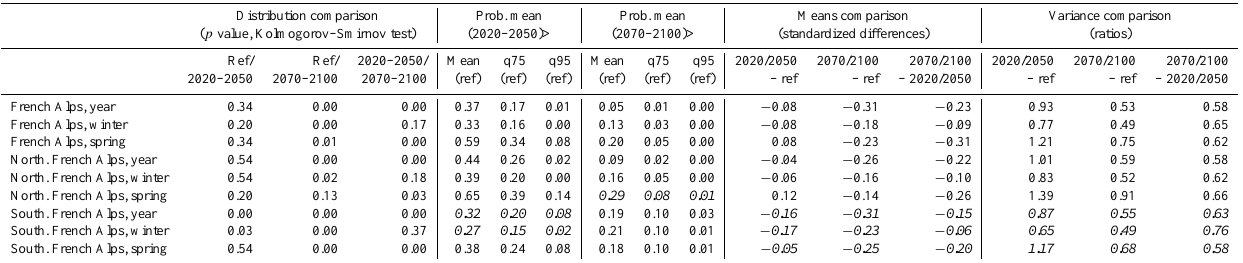
Table 7. Changes in MEPRA index between the reference period and the two future periods. “Ref”, 2020–2050 and 2070–2100 correspond, respectively, to the three considered periods – the reference period (1960–1990) and the middle and end of the 21st century, respectively. Details of the table are the same as for Table